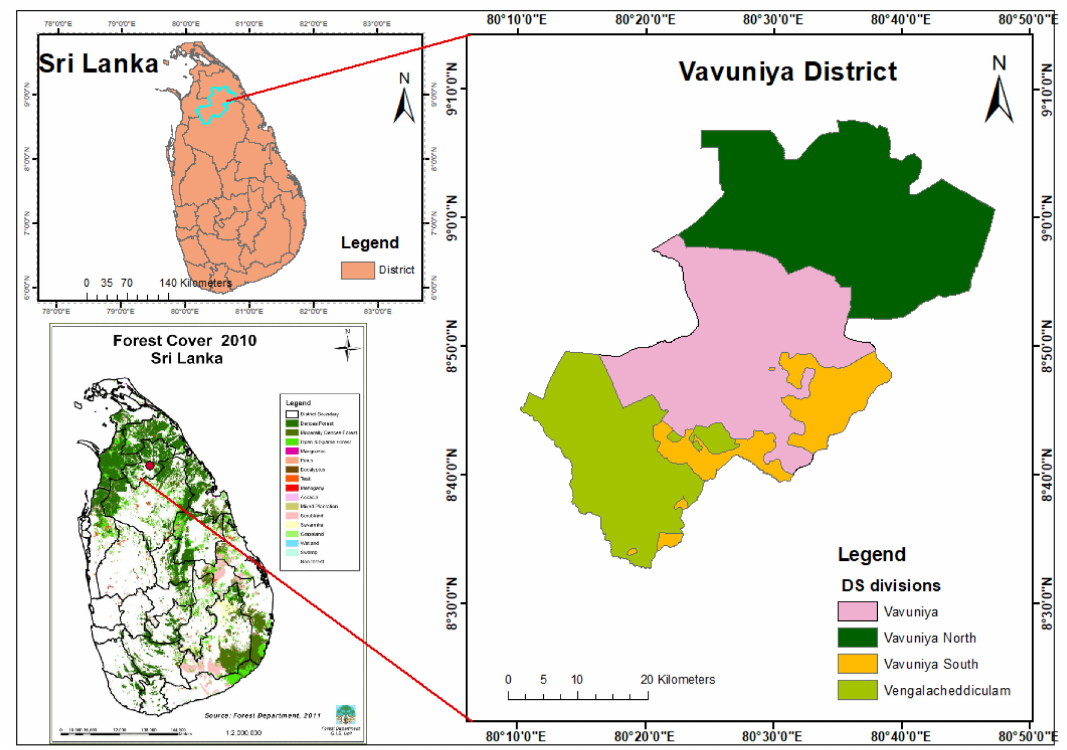
Figure 1. Maps showing the location of the study area in Sri Lanka and its DS divisions, and the forest cover [31] of Sri Lanka in 2010 used to visualize only the forest resources across the